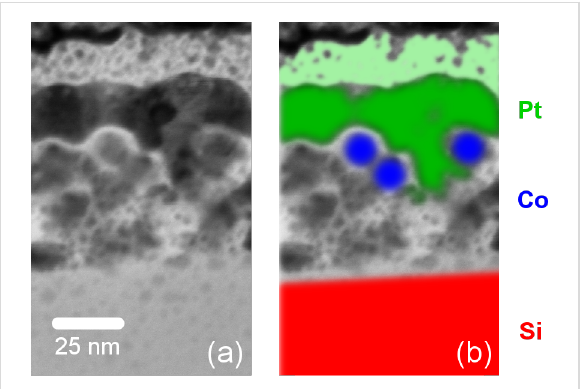
Figure 3: (a) STEM image of the cross section of a plasma-treated sample. (b) As highlighted, the Co particles maintain their spherical shape. The spots in the top Pt layer refer to carbon inclusions due to the preparation process.